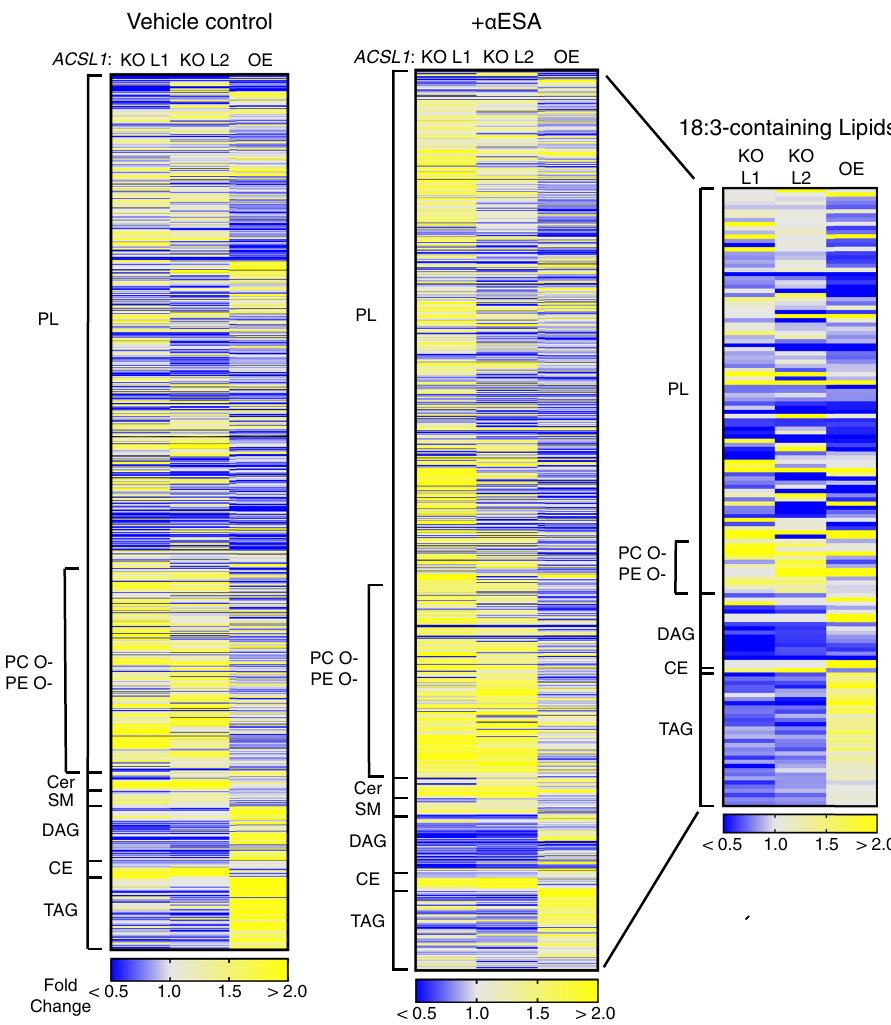
Fig. 6 ACSL1 drives incorporation of α ESA into neutral lipids. Heatmaps representing relative lipid abundance in ACSL1 -de fi cient ( ACSL1 KO L1, L2) or overexpressing ( ACSL1 OE) BT-549 cells as fold-change in mole percent compared to control cells after 16 h treatment with 50 μ M α ESA (right and middle) or in untreated cells (left). The rightmost heatmap shows only the subset of lipids with 18:3 acyl chains. Yellow indicates an increase in relative abundance and blue shows a decrease in relative abundance. PL = phospholipids, CE = cholesterol esters, Cer = ceramide, DAG = diacylglycerol, PC O- = ether-linked phosphatidylcholine, PE O- = ether-linked phosphatidylethanolamine, SM = sphingomyelin, TAG = triacylglycerol. Source data are provided as a Source Data fi